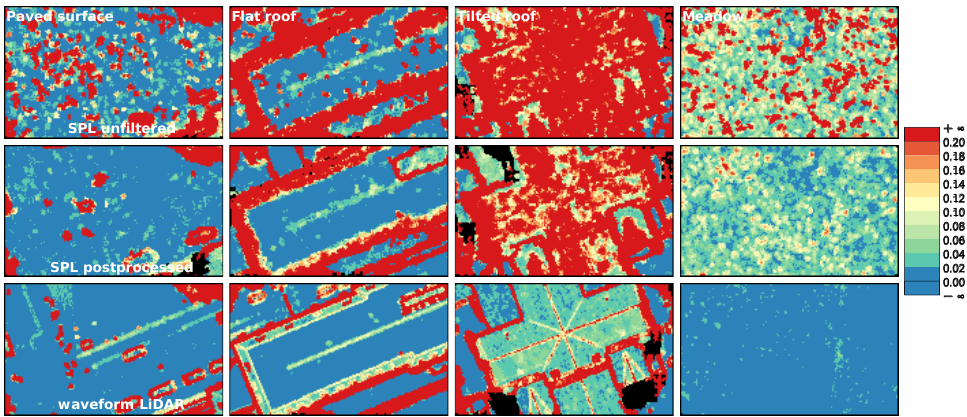
Figure 9. Color coded point cloud dispersion maps (std.dev. [m]) for selected surface patches (extent: 40x24m 2 ); upper row: SPL unfiltered, middle row: SPL postprocessed, lower row: waveform